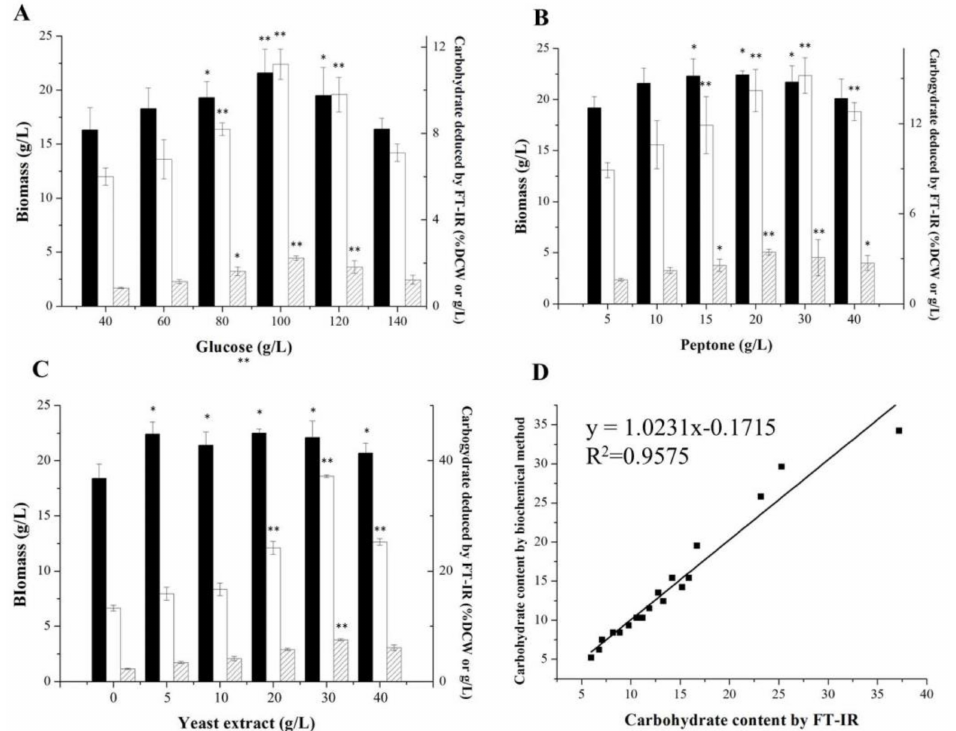
Figure 5. Di ff erent concentrations of glucose, peptone and yeast extract on biomass and carbohydrate productions in Aurantiochytrium sp. strain No. 32 and evaluation of the related FT-IR results. ( A ), E ff ects of concentrations of glucose on biomass and carbohydrate production; ( B ), E ff ects of concentrations of peptone on biomass and carbohydrate production; ( C ), E ff ects of concentrations of yeast extract on biomass and carbohydrate production; ( D ), the linear relationship between the carbohydrate contents deduced by the traditional method and the FT-IR method. Data are given as means ± standard deviation, n = 3. Filled blank, biomass; White blank, carbohydrate content; blank with diagonal, carbohydrate yield. * p < 0.05; ** p < 0.01 The yield under the medium composed of 40 g / L glucose, 10 g / L peptone, and 5 g / L yeast extract was set as the